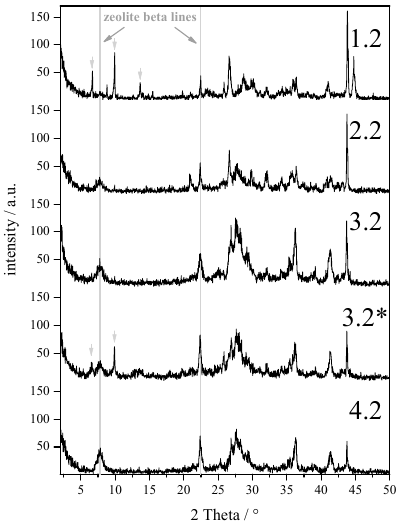
Figure 4. Diffraction patterns of the prepared membranes after the OSDA-free secondary growth step. On series 3.2*, two consecutive OSDA-free secondary growth steps were performed. Impurities of mordenite are marked in the diffraction pattern with an arrow.